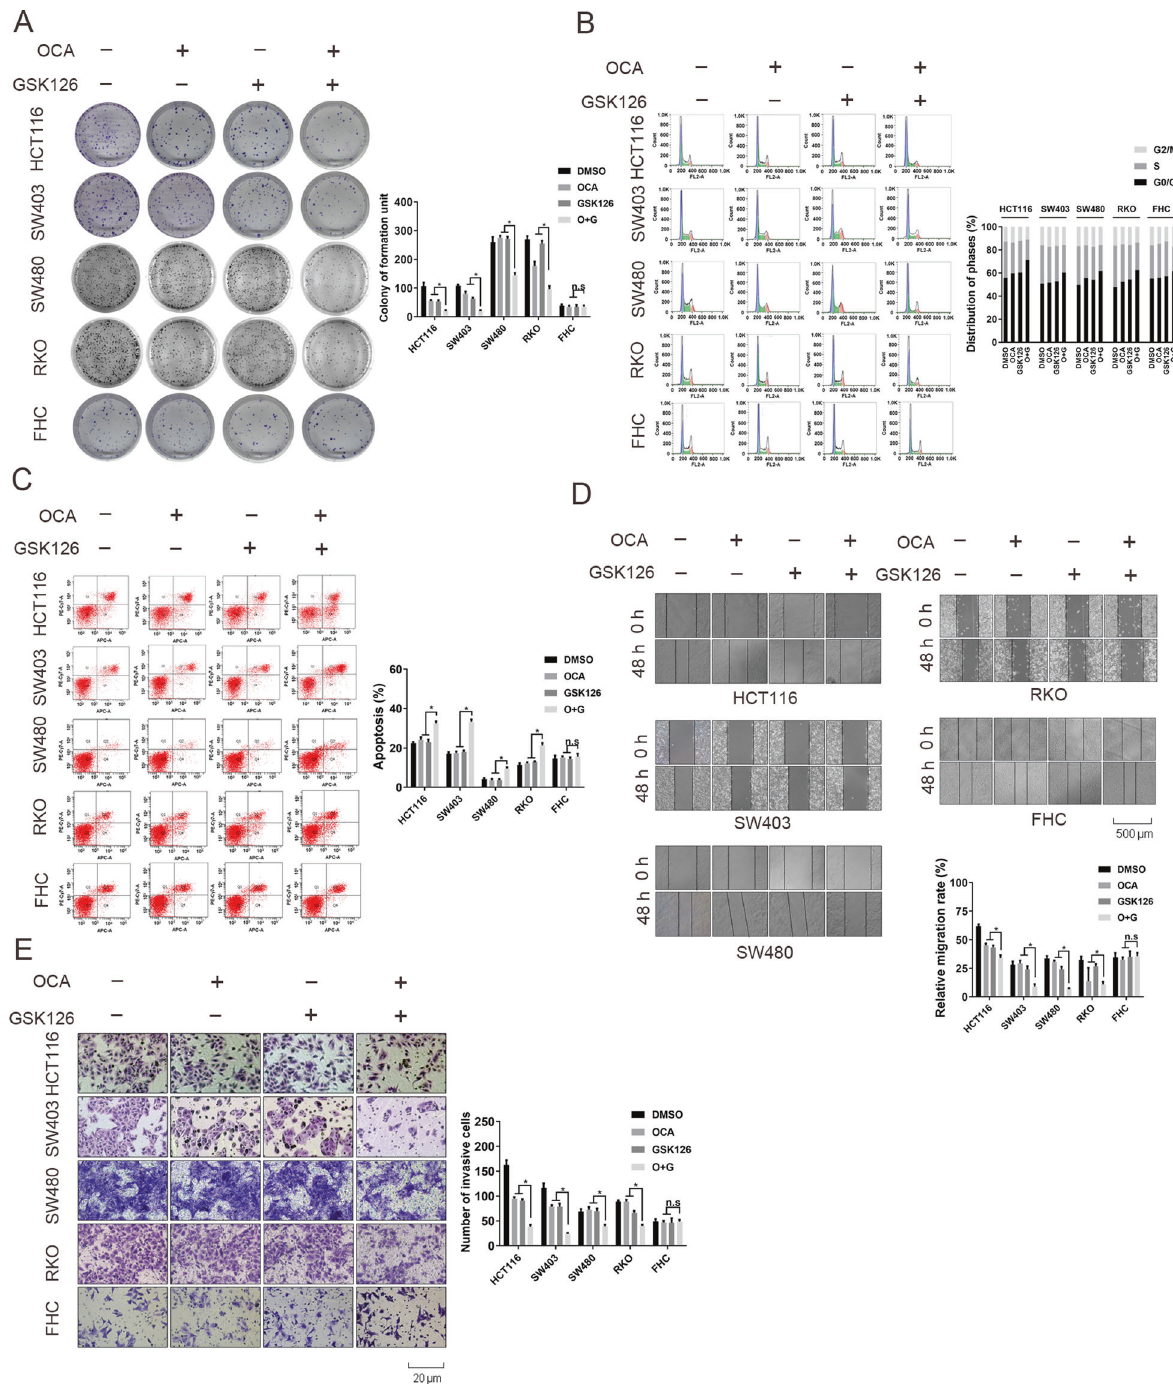
Fig. 3 OCA and GSK126 synergistically inhibited the tumorigenic properties of colon epithelial cells in vitro. a – c The effect of OCA, GSK126 alone, or OCA plus GSK126 on colony formation ( a left panel: colony formation assays; right panel: quantitation of the data), cell cycle distribution ( b left panel: cell cycle analysis assays; right panel: quantitation of the data), and apoptosis ( c left panel: apoptosis assays; right panel: quantitation of the data) of colon epithelial cells. d , e The effect of OCA, GSK126 alone or OCA plus GSK126 on the migration ( d up panel: wound-healing assays; down panel: quantitation of the data).and invasion ( e left panel: transwell assays; right panel: quantitation of the data) of colon epithelial cells. All data are the mean ± SD of three independent experiments. * P < 0.05. several types of cancer, the regulatory mechanism of its growth and blocked CRC progression [37]. Mechanistically, FXR expression is obscure. Henein, we observed a negative clinical antagonized Wnt/ β -Catenin signaling by forming a complex with β -Catenin [26]. The FXR/ β -Catenin complex in turn hinders FXR- correlation between FXR and EZH2 expression in colon cancer tissues. EZH2 promotes transcriptional silencing by methylating mediated transcriptional activation of target gene SHP [26]. histone methyltransferase H3K27 [38]. Increasing evidence Despite of the involvement of FXR in onset and progression of Cell Death and Disease